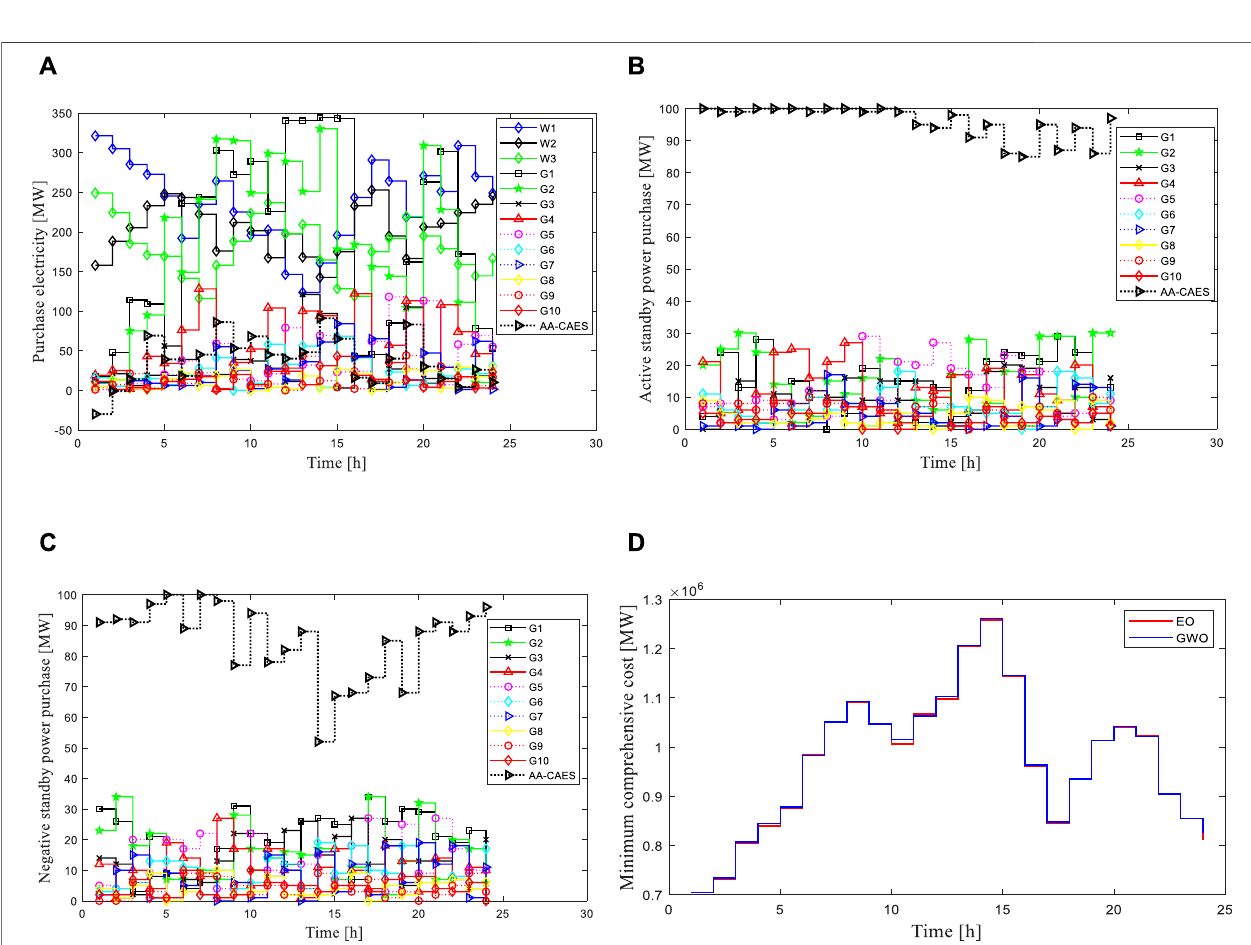
Frontiers in Energy Research |